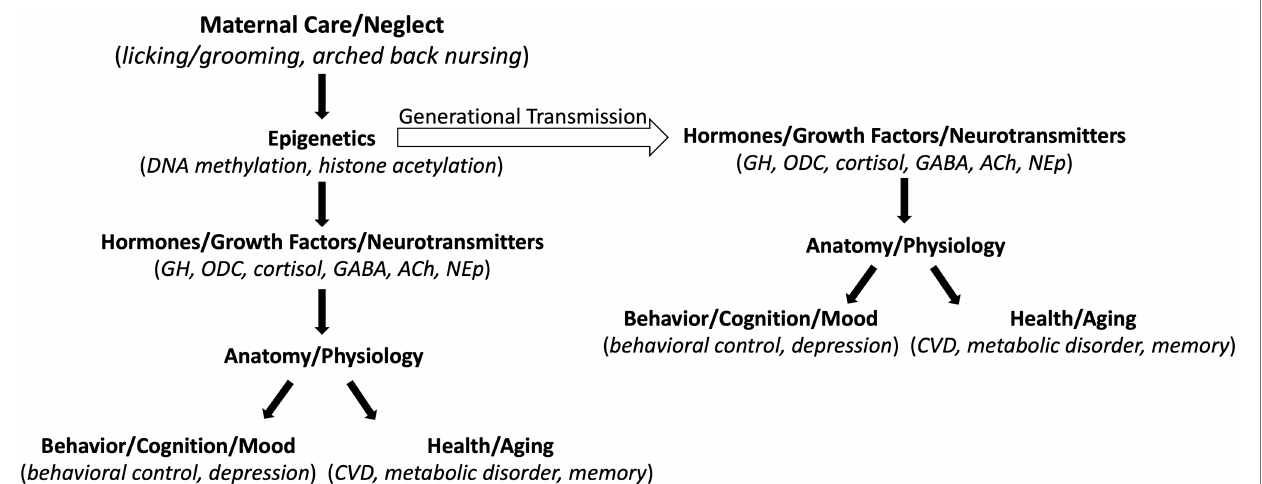
FIGURE 1 | Schematic of the downstream effects of maternal care. Maternal care alters gene expression (Epigenetics) in the offspring that then alters expression of various molecules (Hormones/Growth Factors/Neurotransmitters) that impact quality of life (Behavior/Cognition/Mood) and longevity (Health/Aging). The Epigenetic effects can be transmitted across generations to alter phenotypes in subsequent generations. GH, growth hormone; ODC, ornithine decarboxylase; GABA, gamma- aminobutyric acid; ACh, acetylcholine; NEp, norepinephrine; CVD, cardiovascular